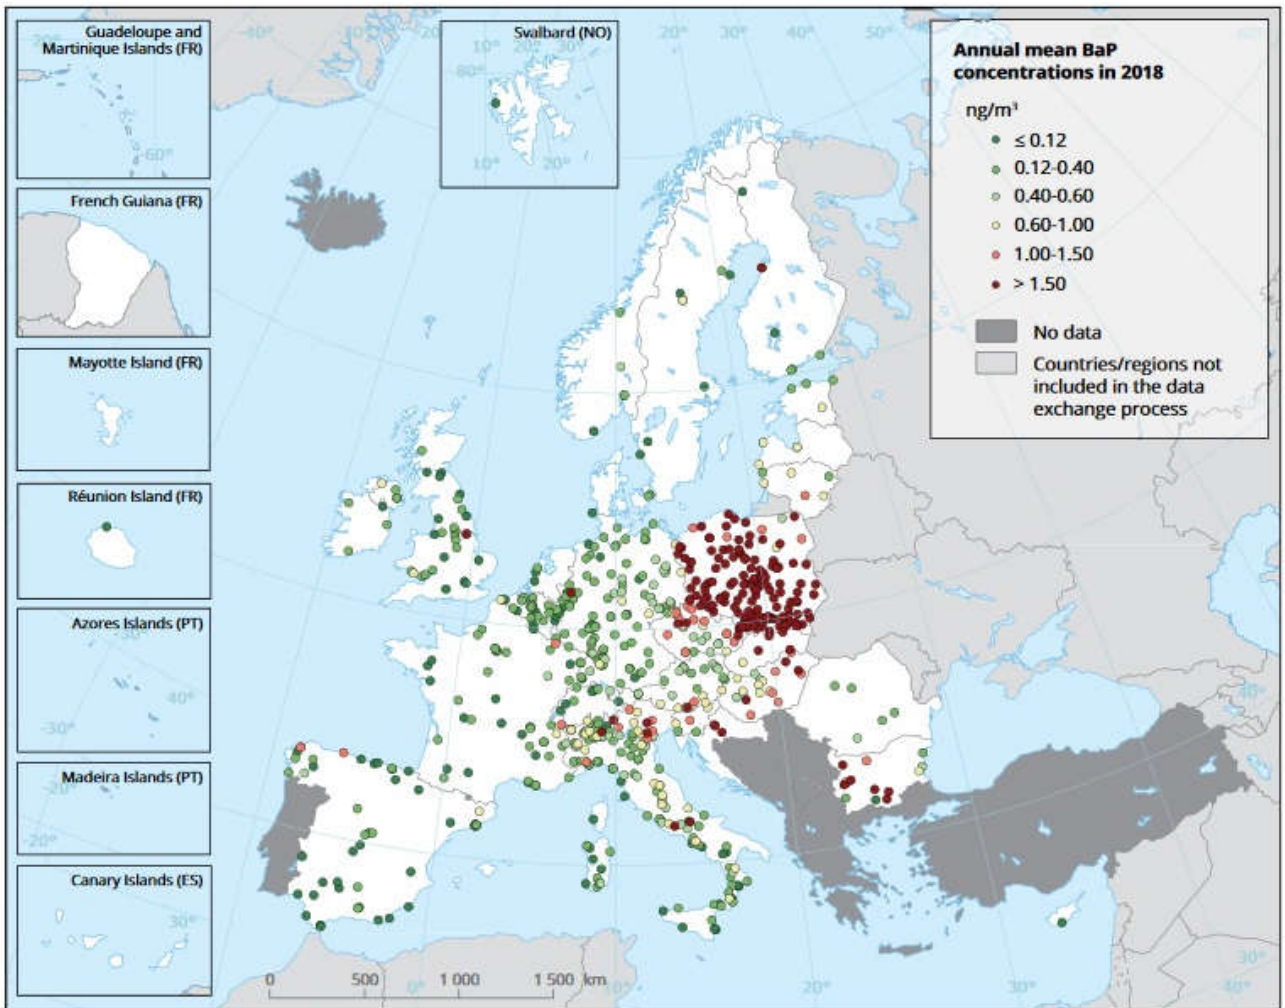
Figure 1. Observed concentrations of BaP in 2018. Data taken from reference [14]. Renewable energy sources (RES) are an alternative to conventional fuels. At present, this is the only possible way to prevent the harmful effects of smog and climate change in Poland, as the country does not possess nuclear power plants. In addition, the use of renewable energy is also perceived by the public as a step towards environmental protection and sustainable